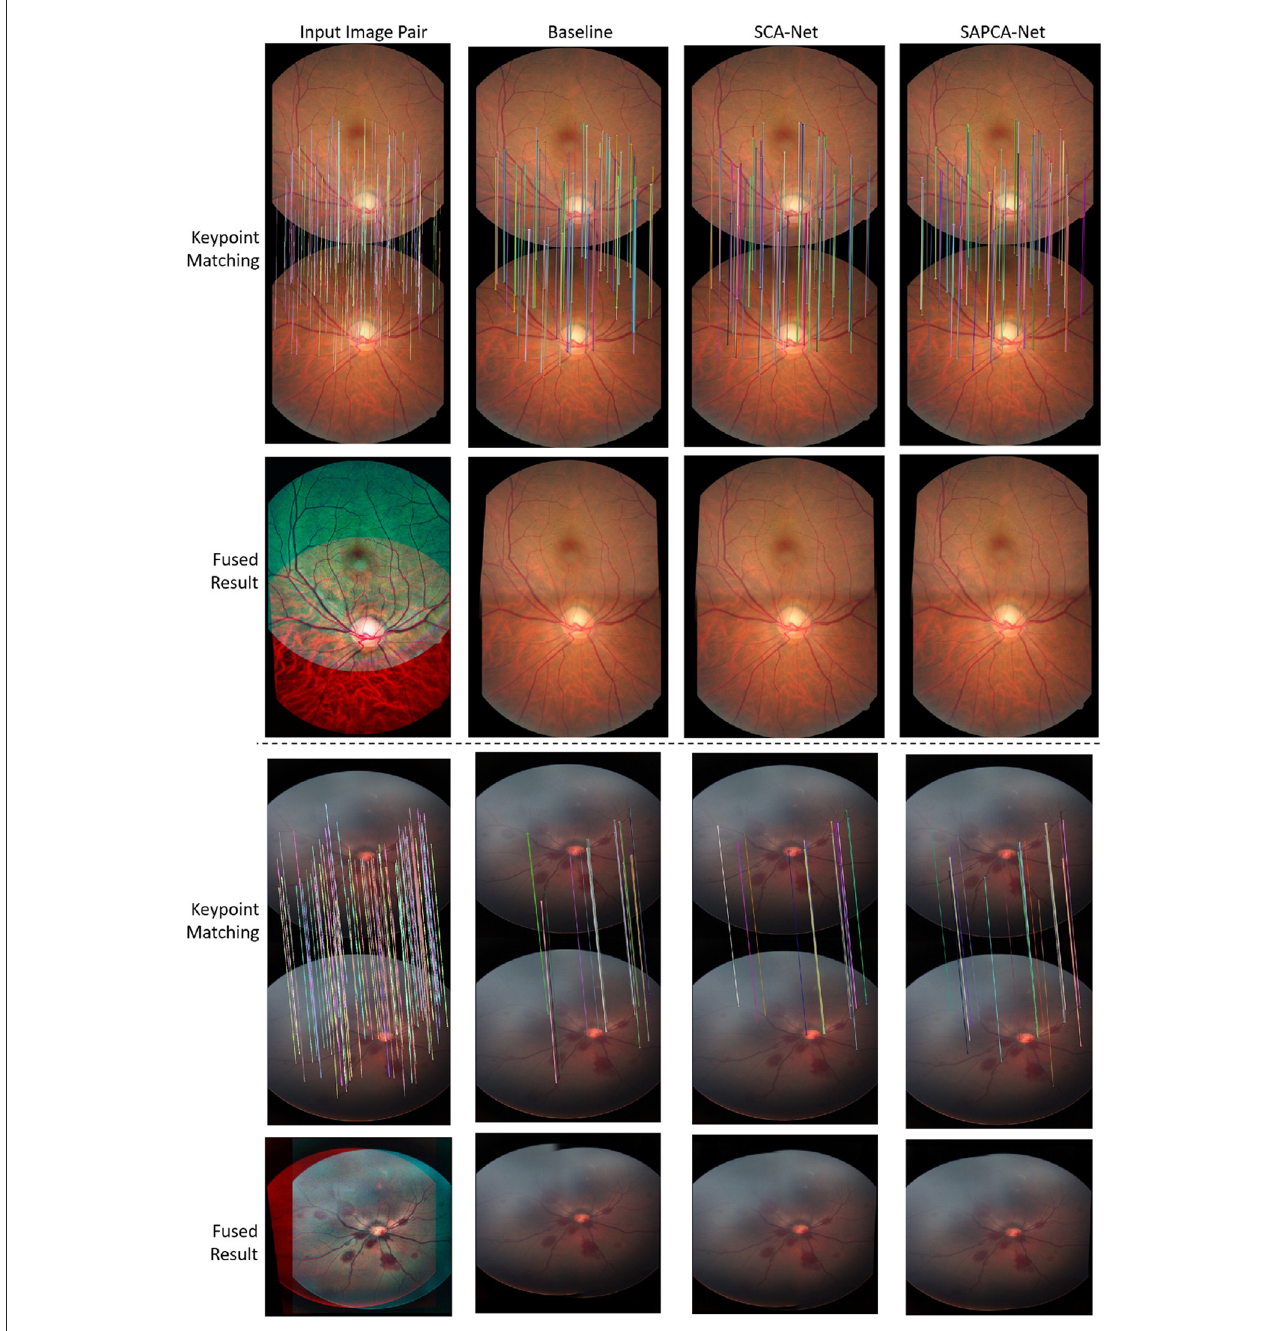
FIGURE7 Example of the keypoint detection and matching results of normal adult and neonatal fundus images. We also show the fused image with the matching keypoints.